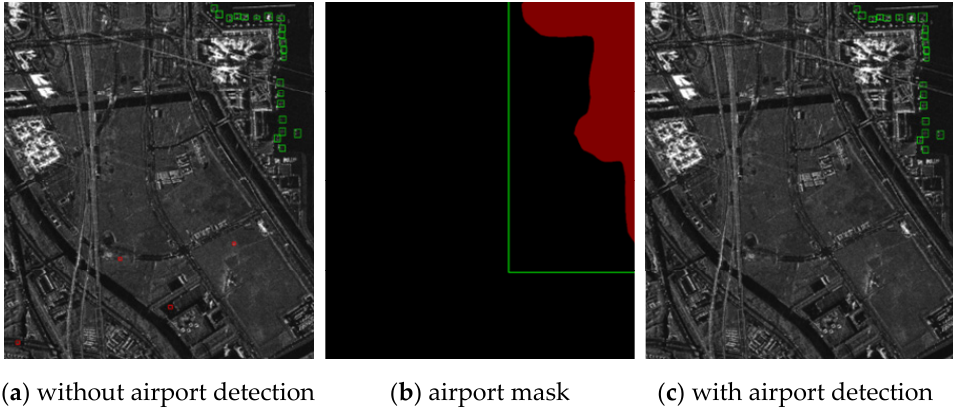
Figure 10. Effectiveness of the proposed airport detection algorithm. The green box represents the correctly detected aircraft, and the red box represents false alarms.